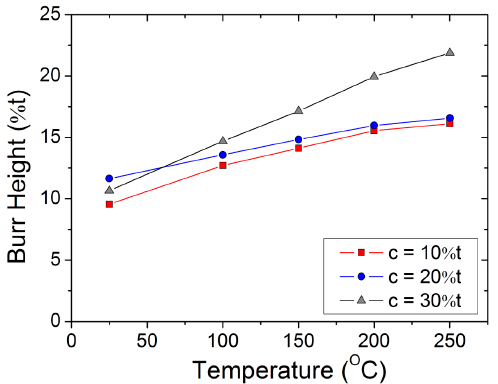
Figure 10. Relationship between burr height (expressed as a percentage of the workpiece thickness) and heating temperature for various punch–die clearances.